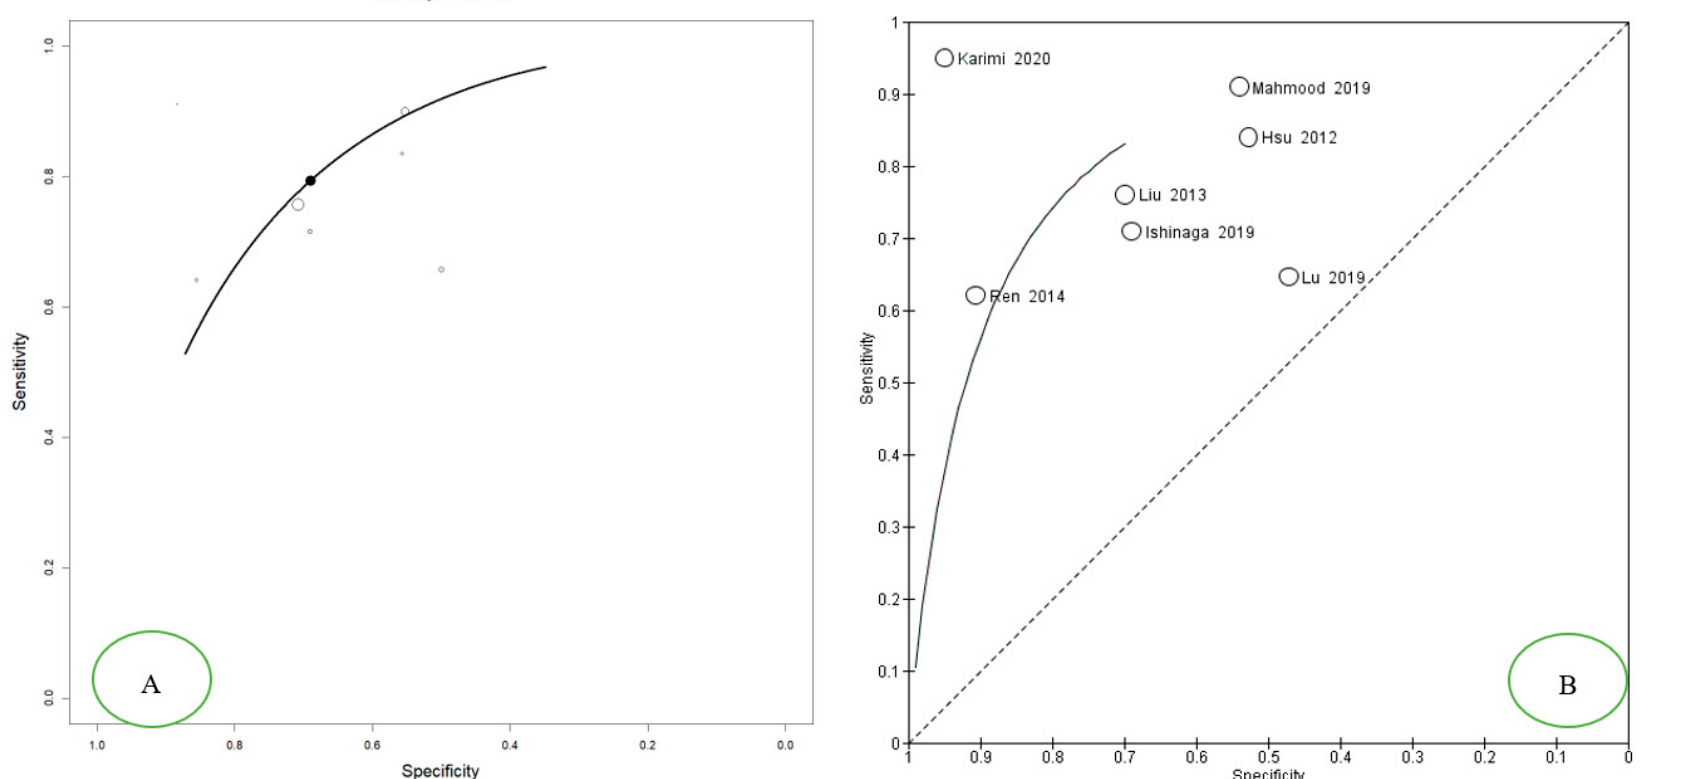
Figure 5. The Summary ROC curve is intended to summarize the relationship between the TPR (true positive rate—sensitivity) and FPR (false positive rate—specificity) across the set of studies. ( A) Summary ROC Curve Open Meta-Analyst version 10, the optimal position between the TPR and FPR response to individual studies is highlighted on the SROC with a black point; ( B) Summary ROC Curve Reviewer Manager 5.3, the position of the individual studies with respect to the Summary ROC is highlighted .